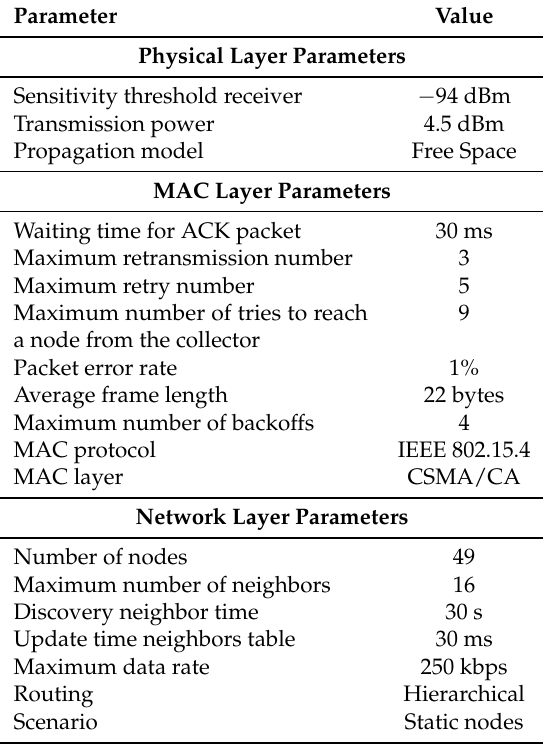
Table 1. Simulation and real network parameters. CSMA/CA, carrier sense multiple access with collision avoidance